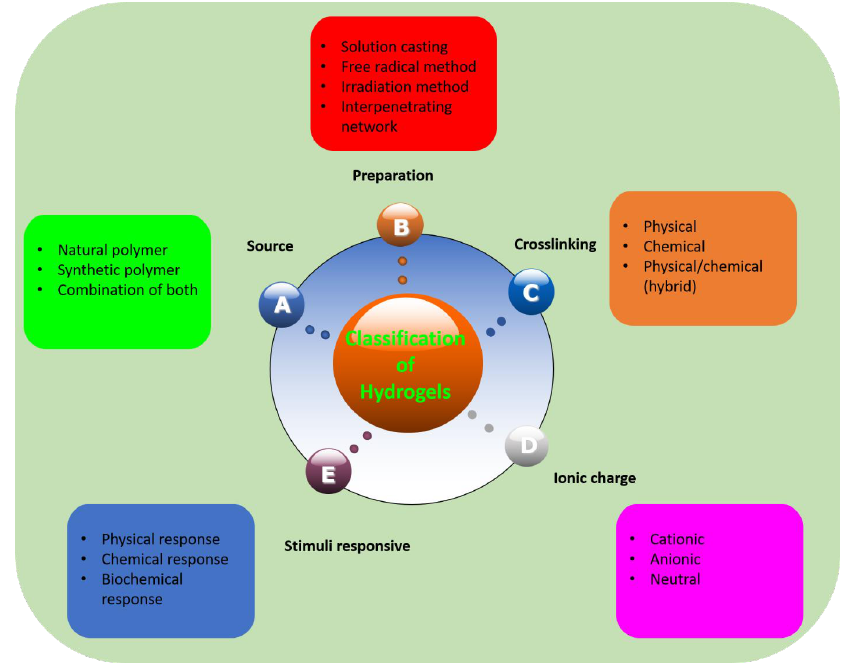
Figure 1. Classification of hydrogels.